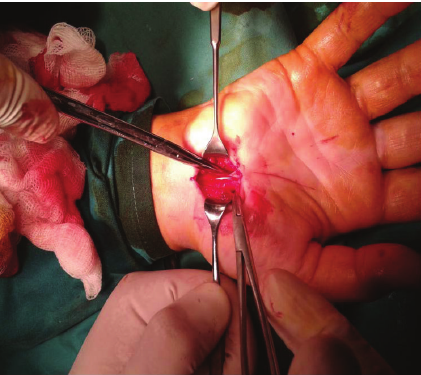
Figure 1: Palmaris profundus in carpal tunnel during the first surgery.